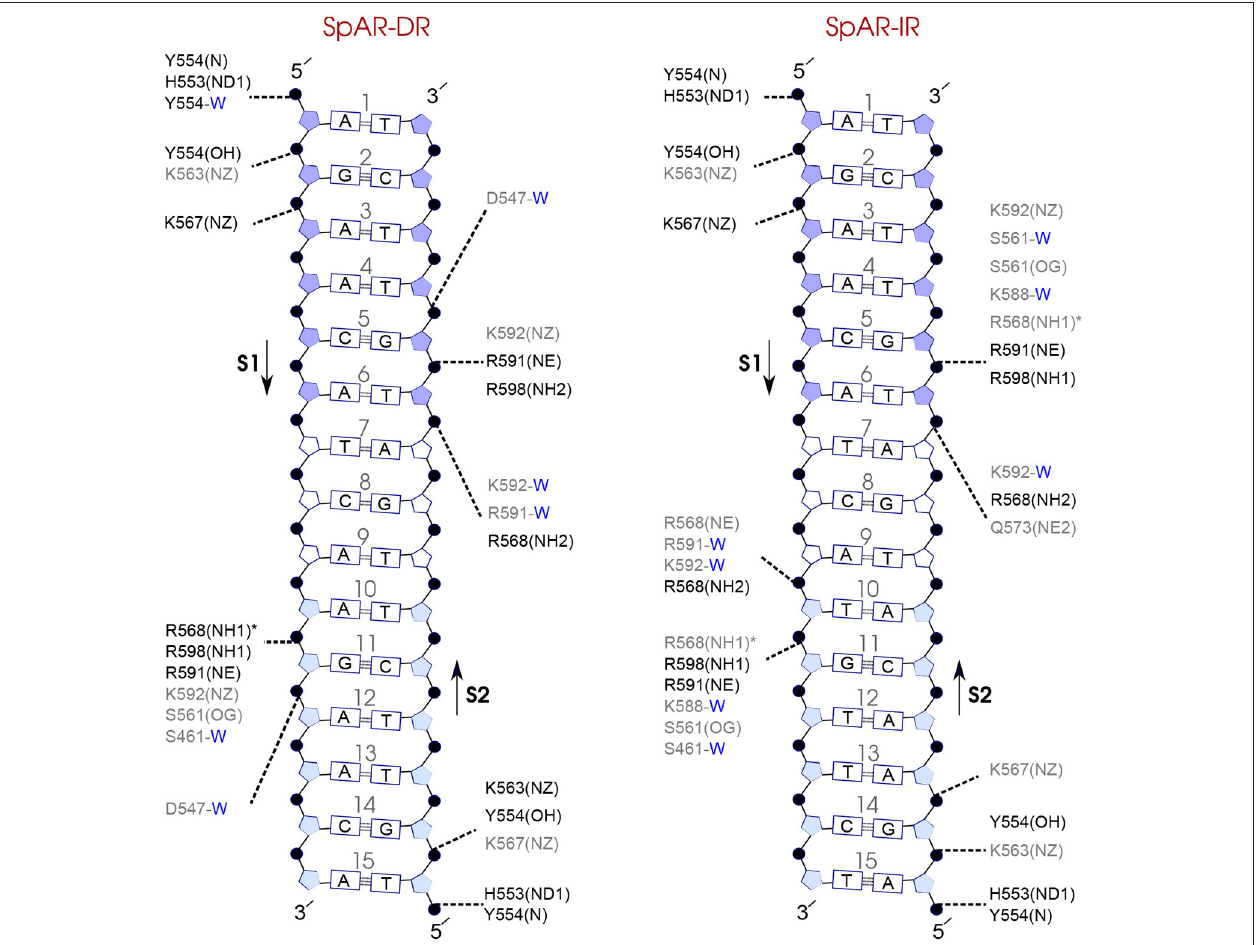
FIGURE 8 | Diagram of protein-DNA hydrogen-bond interactions for (left) SpAR-DR and (right) SpAR-IR. The nucleotides of the 15 bps core DNA sequence are numbered from HS1 (numbers: 1–6) to HS2 (numbers: 10–15). The spacer region is highlighted with non-colored boxes around the numbers of the bases (numbers: 7–9). The hydrogen bonds are categorized based on their occupancy, 50–75% (gray), and 75–100% (black). The water mediated hydrogen bonds are shown with a blue letter “W.” The residues shown with star sign form base-specific hydrogen-bond interactions while the other residues interact with the backbone of the